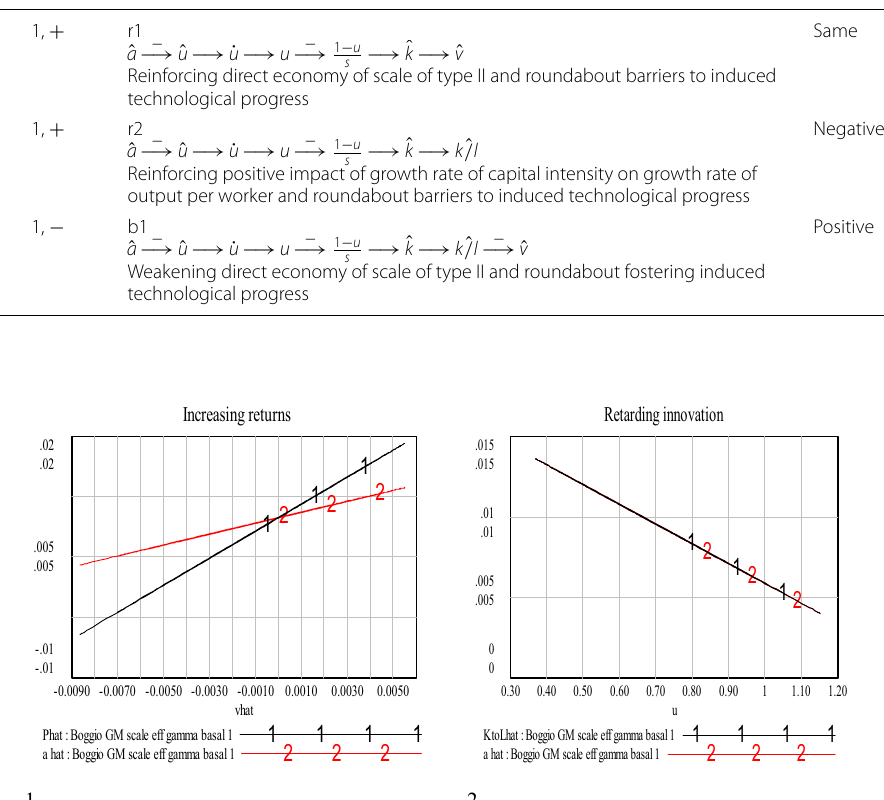
Table 6 Endogenous growth of output per worker in refined extensive B-1 retained in L-1 No. Order and